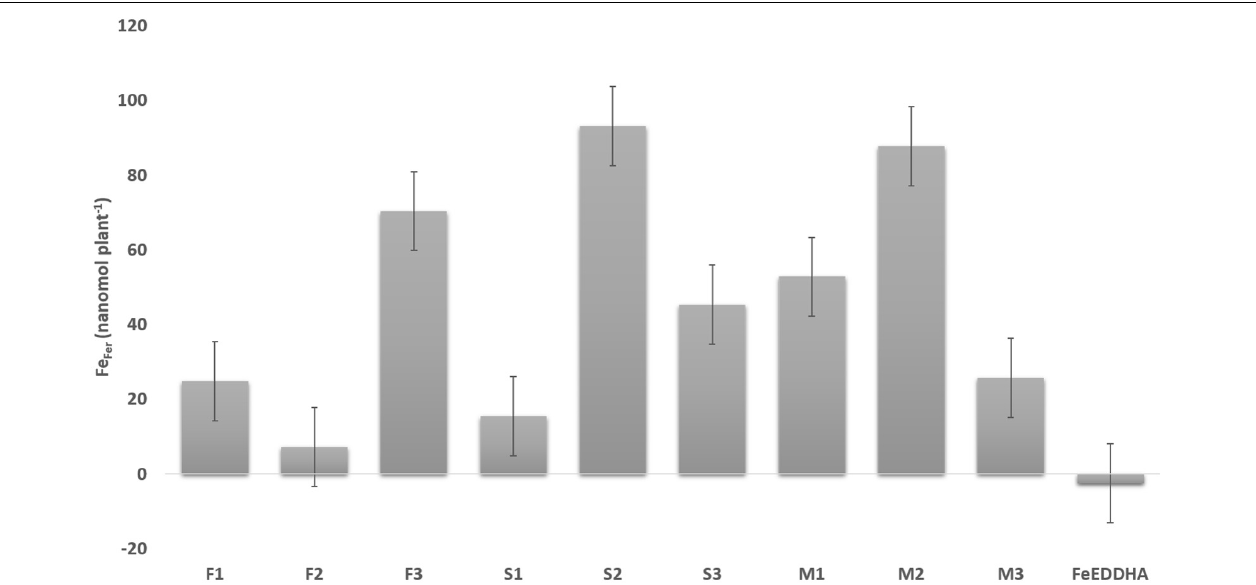
FIGURE 7 | Differences in Fe Fer uptake (%) in soybean leaves of plants fertilized with the 57 Fe products F, S, and M in three doses: (1) 35, (2) 75, and (3) 150 µ mol 57 Fe pot − 1 or 50 µ mol 57 FeEDDHA pot − 1 , between the first (15 DAF) and the second sampling (48 DAF). Results are expressed as averages ± standard error, n = 5.